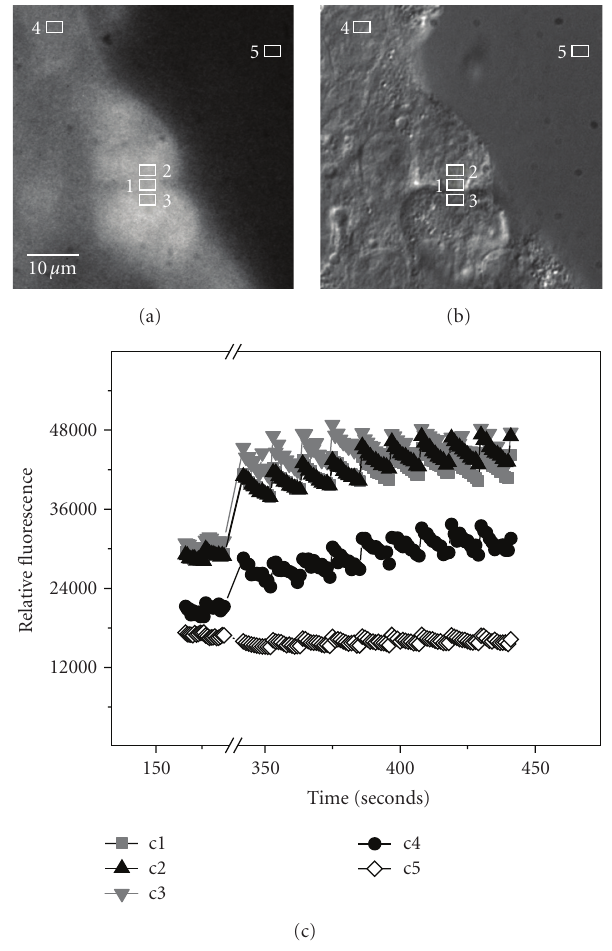
Figure 4: Sites of calcium transients during mitosis . Calcium tran- sients correspond with sites of CaV1 immunofluorescence in AtT- 20 Cells during mitosis. Simultaneous imaging of (a) Fluo4 (4 μ M) intracellular calcium transients and (b) cell morphology by DIC in AtT-20 cells during cytokinesis. Regions: 1 = midbody; 2, 3 = spindle mid-zone; 4 = nuclear region of interphase cell; 5 = background (media only). (c) Plot of fluorescence units for each region over time (sec). Regions of enhanced calcium transients correspond to midbody (1) and spindle mid-zone (2, 3). Break in X-axis marks time of acquisition following loading of